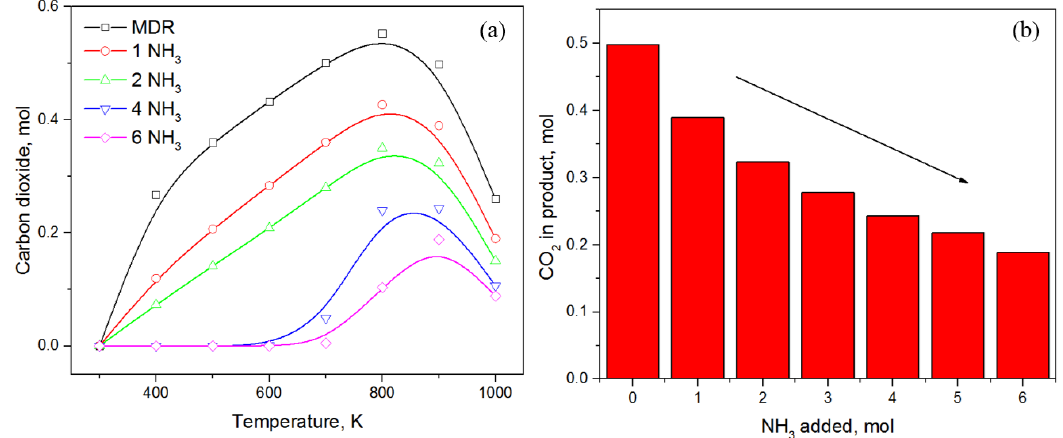
Figure 5. ( a ) Effect of ammonia content in DMR on CO 2 in product; ( b ) a decreasing trend in CO 2 amount in presence of NH 3 at 900 K.